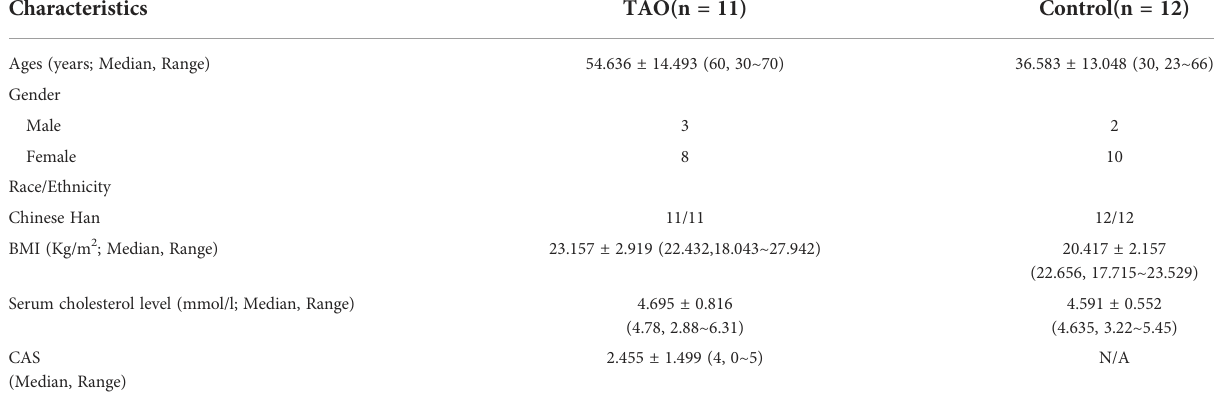
TABLE 1 Information of human subjects included in this study for metabolite analysis.